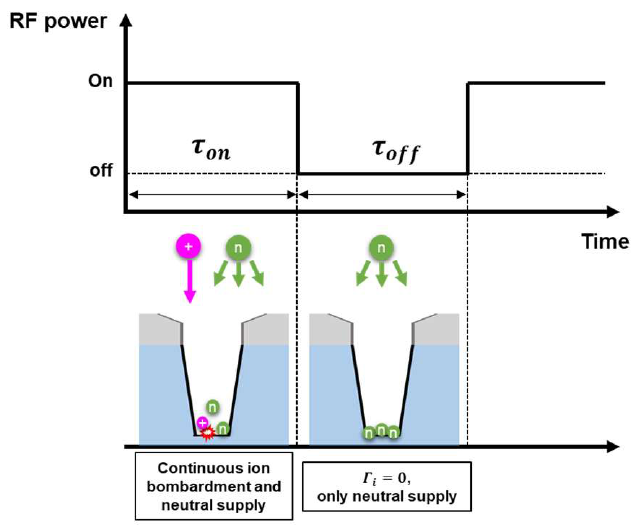
Figure 5. A simple pulsed plasma model.